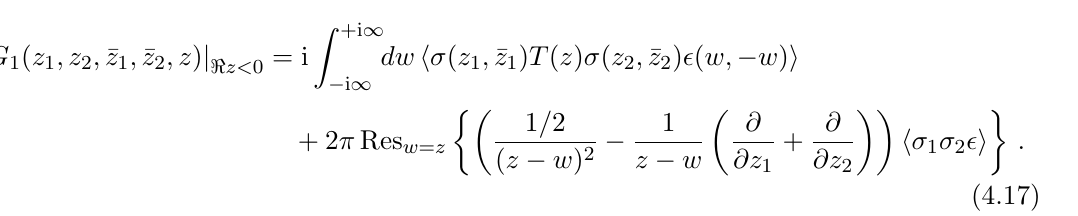
; z lie on the left, 1 2 and 1